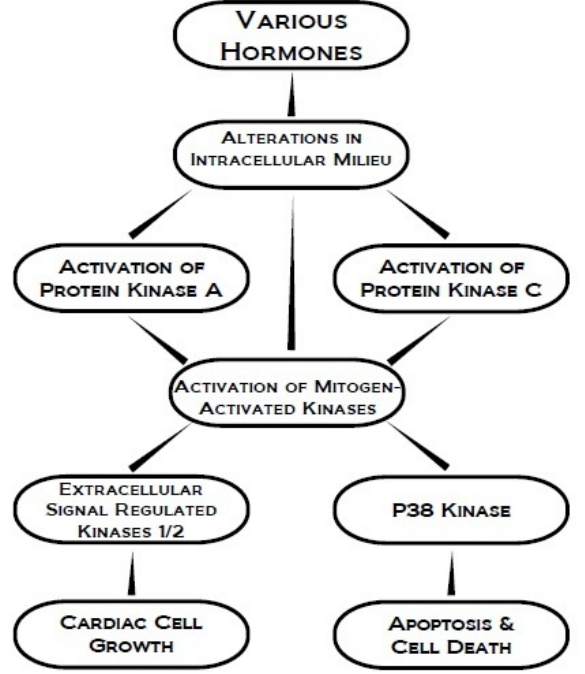
Figure 1. Schematic representation of the integrated involvement of some protein kinases in signal transduction for cardiac cell growth, apoptosis and cell